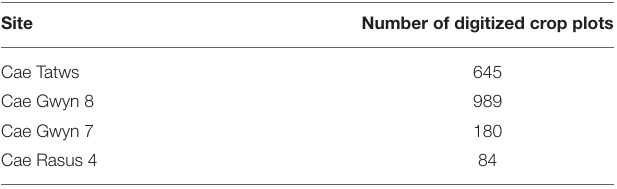
TABLE 2 | Datasets with the number of corresponding crop plots digitized for each validation set.